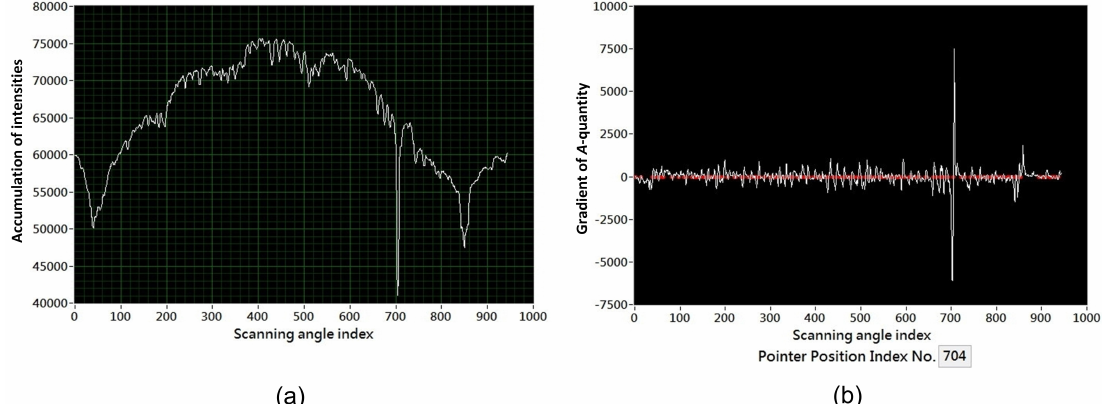
Figure 13. Results obtained by our scanning process. The profiles of ( a ) A ( i ) , and ( b ) GA ( i ) , ∀ i , were determined by means of the method presented in Section 3.2. According to Equation (20), the detected index was k = 704 with the corresponding θ ( 704 ) = 118.405 ◦ , which is the pointer’s position ( θ p ) in the current